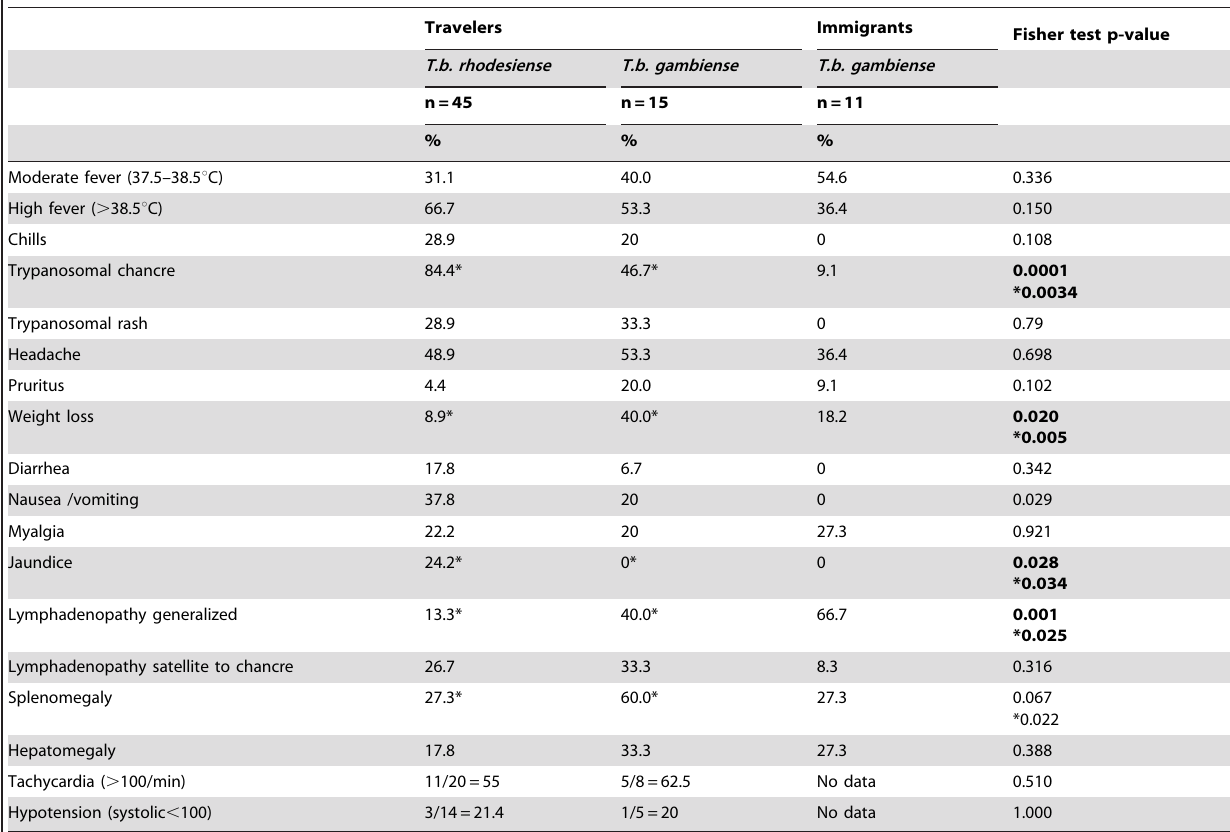
Table 2. Clinical signs and symptoms.